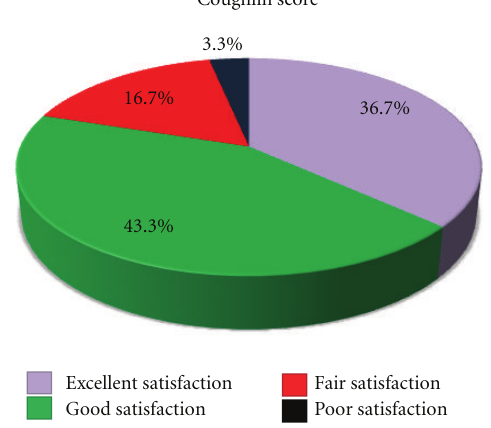
Figure 8: Patient satisfaction Coughlin score at final follow-up. The preoperative and final follow-up AOFAS and MOCART scores were correlated using the Student’s t- test finding a P value